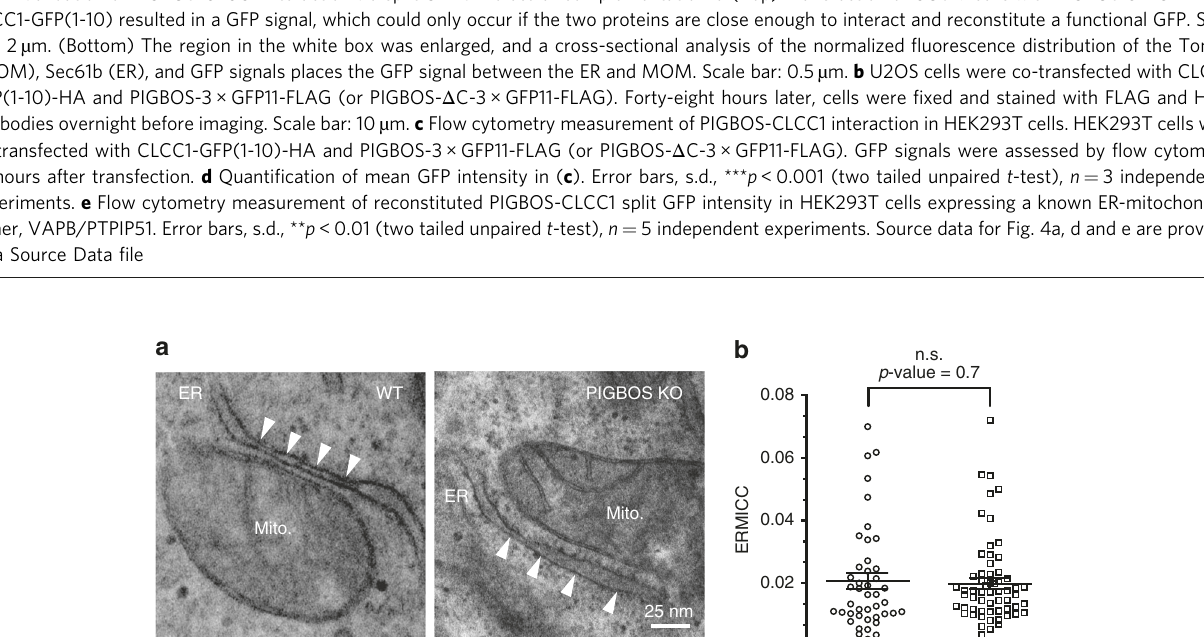
Fig. 5 PIGBOS shows no effect on modulation of ER-mitochondria contacts. a Representative transmission electron microscopy images from WT and PIGBOS-KO U2OS cells showed no remarkable differences in ER-mitochondria contacts. ER and mitochondria contact sites are indicated by white arrows. b Quantitation of the normalized ER-mitochondria contact coef fi cient (ERMICC) did not identify a signi fi cant difference between ERMICC of WT vs. PIGBOS-KO U2OS cells. Data are collected from two independent experiments and pooled from 43 WT mitochondria (eight cells), and 62 PIGBOS-KO mitochondria (seven cells) and the bar graph is the ERMICC± s.e.m. with the p -value calculated using two tailed unpaired t -test with all data points included in the calculation. Source data for Fig. 5b are provided as a Source Data fi